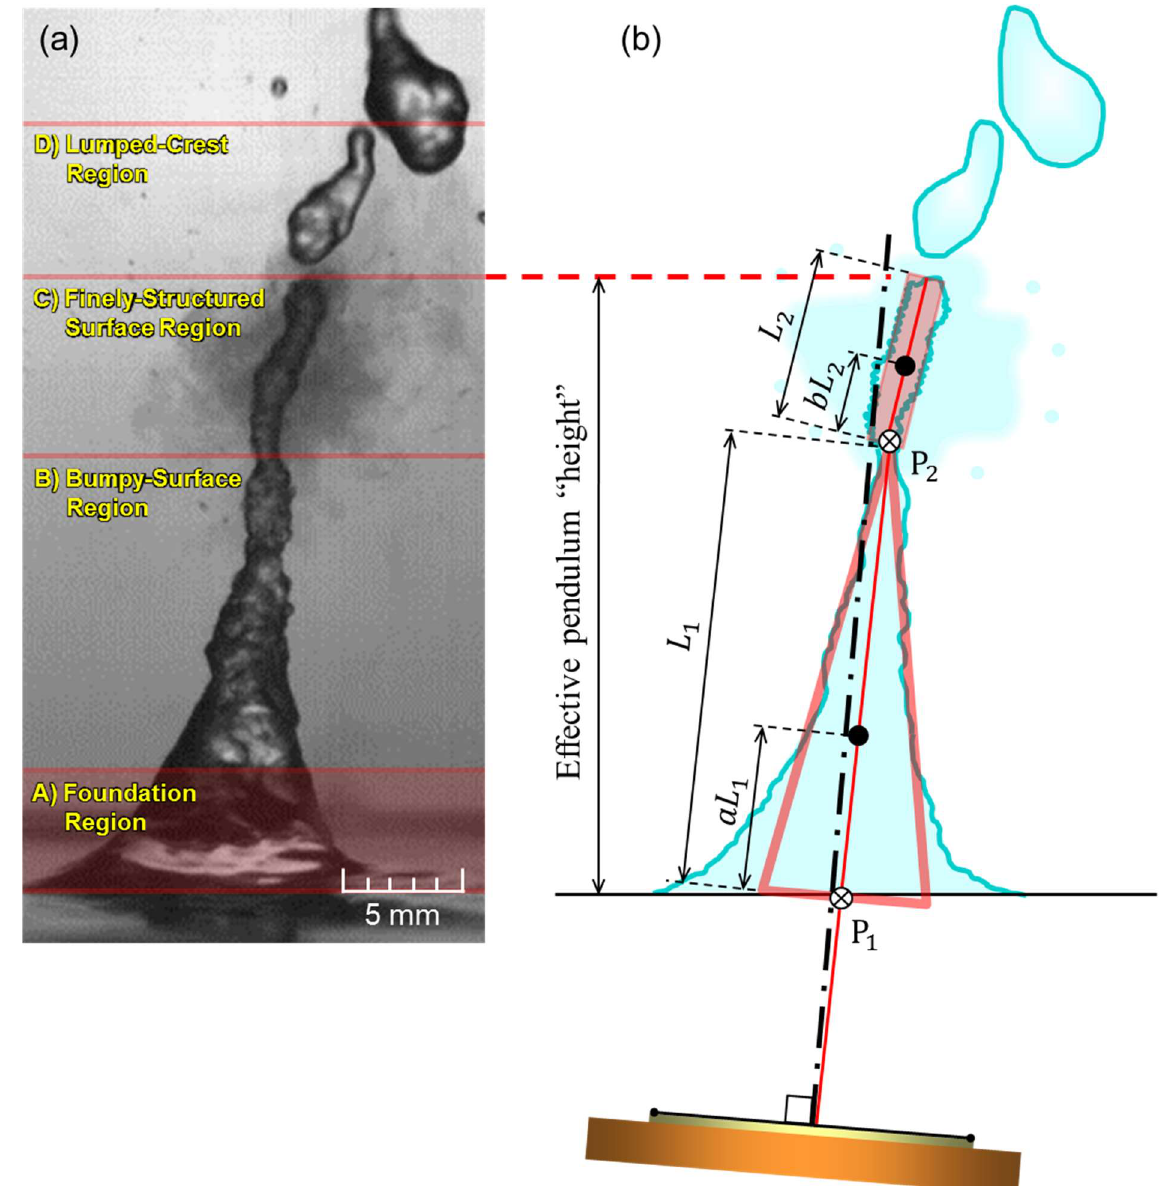
Figure 7. ( a ) General configuration of acoustic liquid fountain, proposed by Tsuchiya et al. [19], based on dynamics of four-region structure realized on typical fountain image, and ( b ) schematic representation of comprehensive definitions as well as specifications towards swinging fountain model.